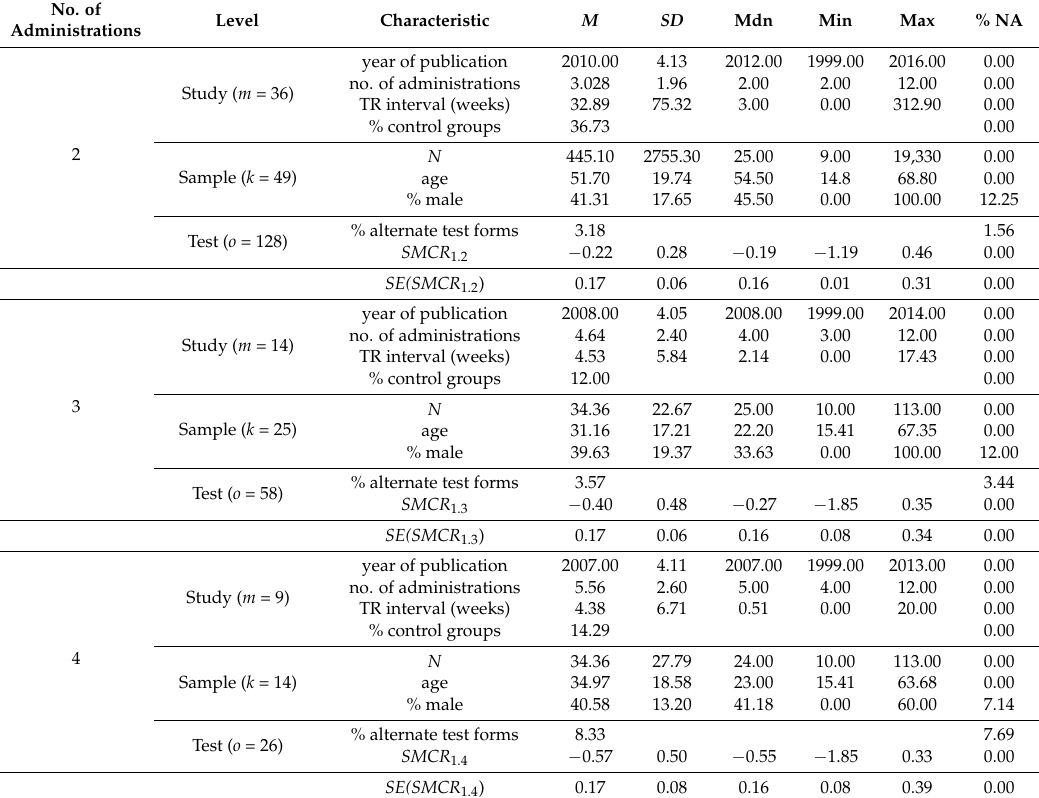
Table 1. Study, Sample and Test